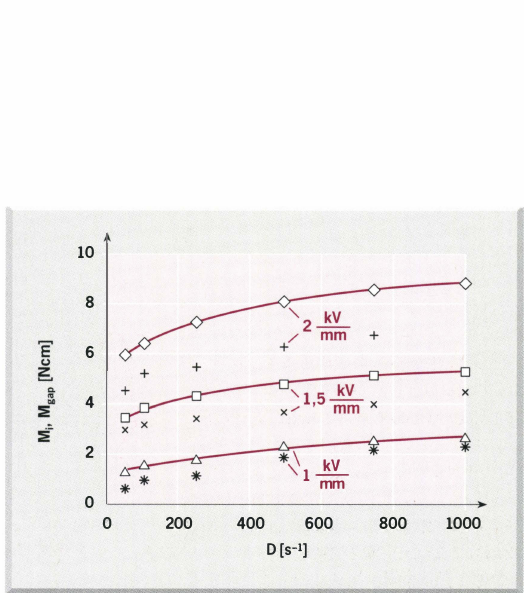
Abb. 5: Scherrateabhiingigkeit der Drehmomente M; (Symbole: <>. D,t.} und